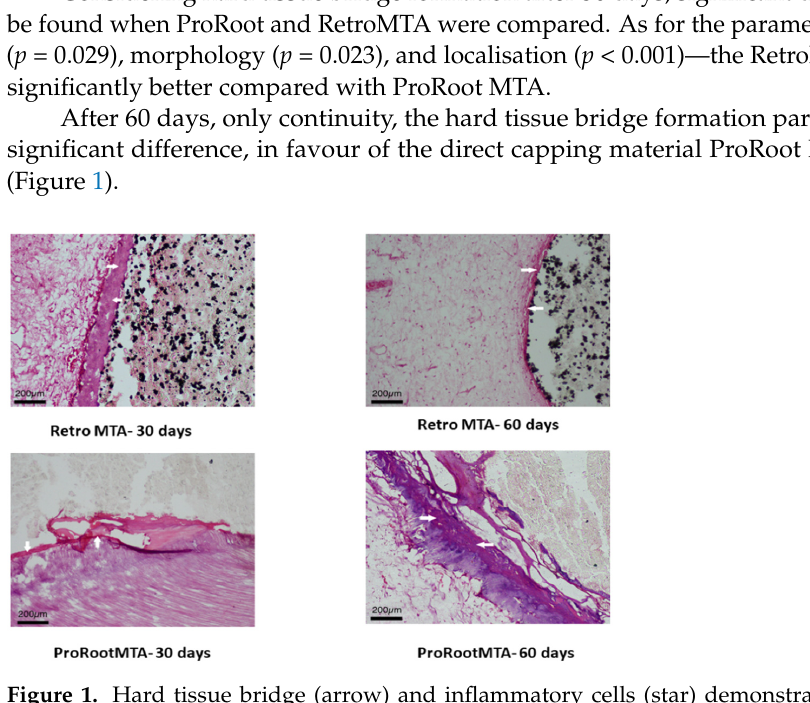
Figure 1. Hard tissue bridge (arrow) and inflammatory cells (star) demonstrated in relation to ProRoot MTA and RetroMTA at 30 days and 60 days (haematoxylin and eosin, original magnification ×